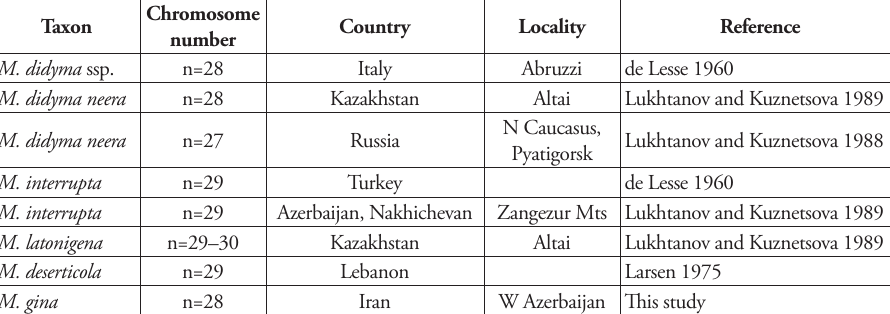
Table 3. Chromosome numbers of taxa close to M. didyma